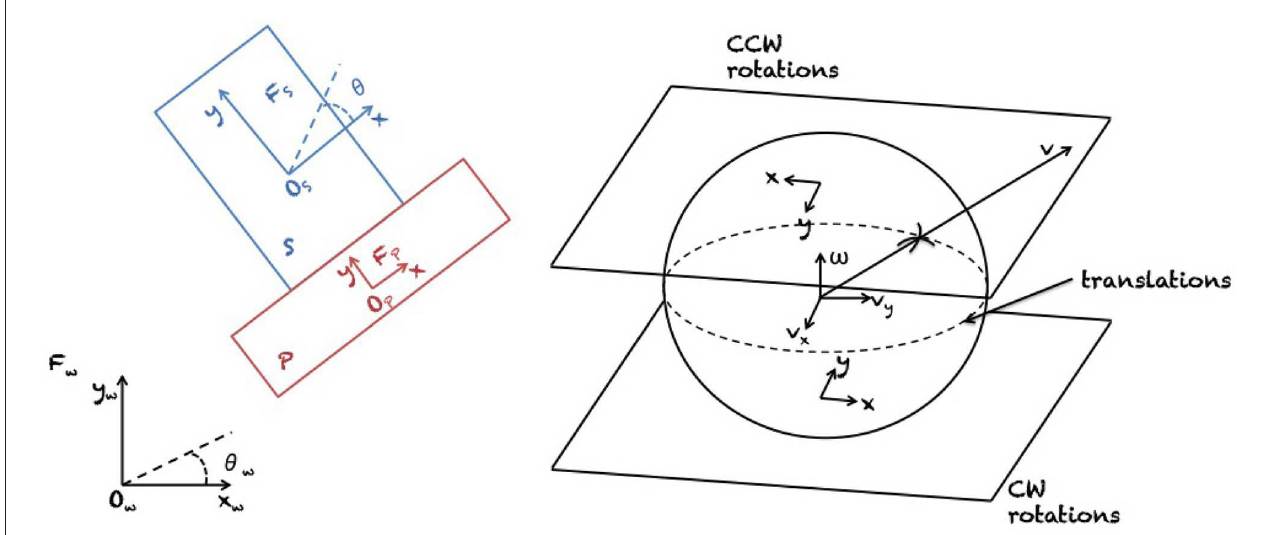
FIGURE 3 | The slider S (blue) is a rigid object in the plane R 2 , and its configuration space is R 2 × 2 , i.e., 2D translation and one rotation over the x − axis. The slider is pushed by a rigid pusher P (red) at a point or set of points of contact. A world frame F w with origin O w is fixed in the plane, and a slider frame F w with origin F s is attached to the center of friction of the slider S . The configuration ( x w , y w , θ w ) ⊺ describes the position and orientation of the slider frame F s relative to the world frame F w . Similarly, a pusher frame F p with origin O p and its configuration is computed. On the right side of the figure, the relation between the unit motion vector v = ( v x , v y , ω ) ⊺ and the center of rotation of frame F s is described by the projection shown from the unit motion sphere to the tangent planes (one for each rotation sense). The line at the equator of the sphere represents translations. Reproduced from Lynch and Mason